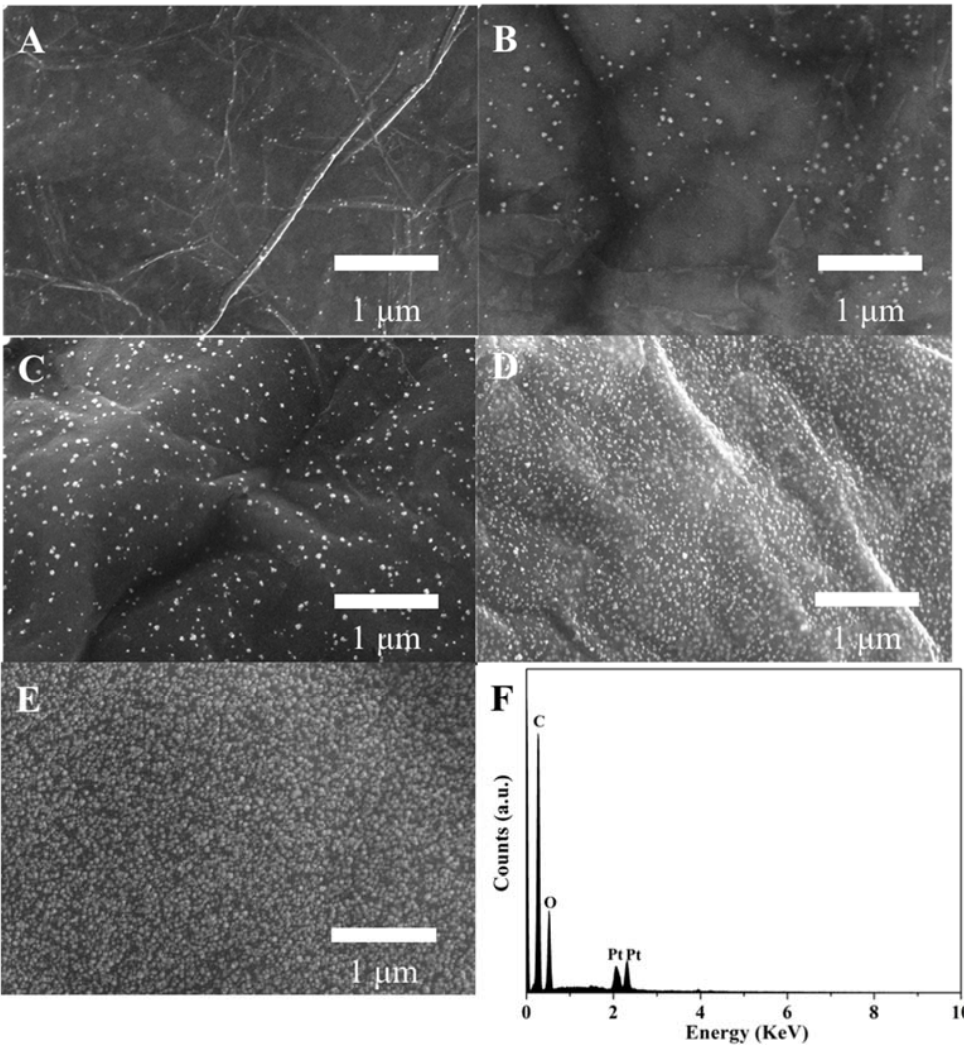
Figure 5. FESEM images of PtNPs on rGOP ( A – E ), with different deposition cycles and its ( F ) EDX analysis.